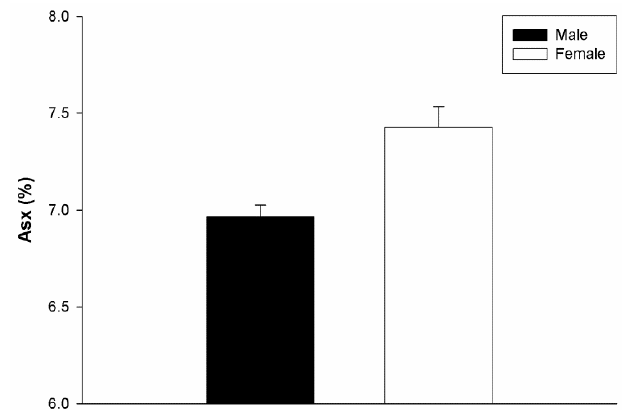
Figure 5. MBP is more highly racemized in females. Racemisation of aspartic acid + asparagine (Asx) in the MBP of age-matched male ( ) and female ( ) subjects. Elevated levels of D -Asx were found in females by comparison to males ( p = 0.029, Mann–Whitney U test). Male n = 4, female n = 4, age range 51–87 years. Mean ± SEM.